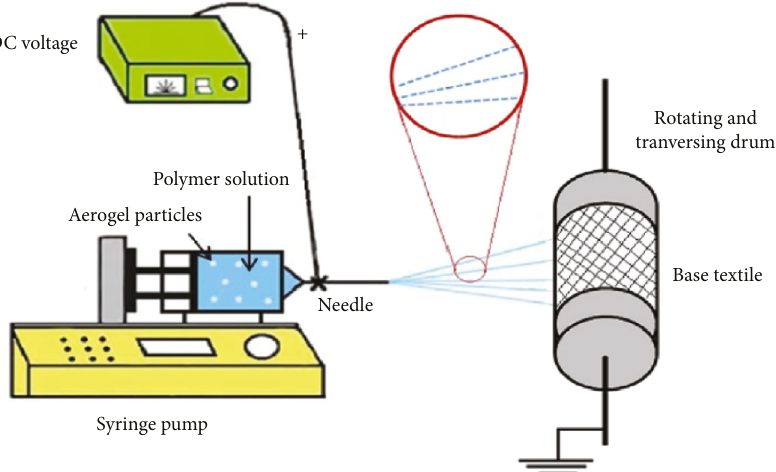
Figure 13: Schematic diagram for the electrospraying of aerogel particles on the textile substrate